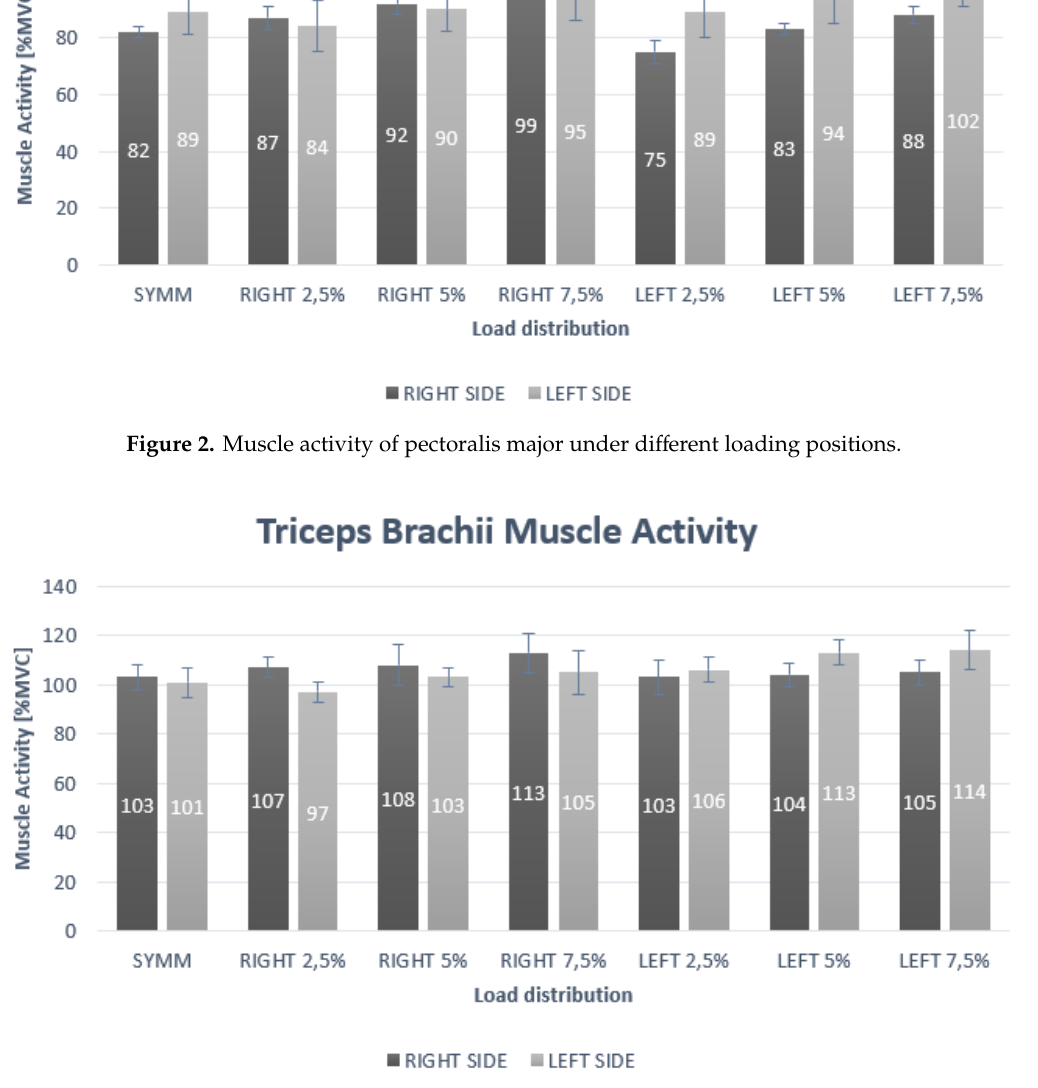
Figure 3. Muscle activity of triceps brachii under different loading positions.